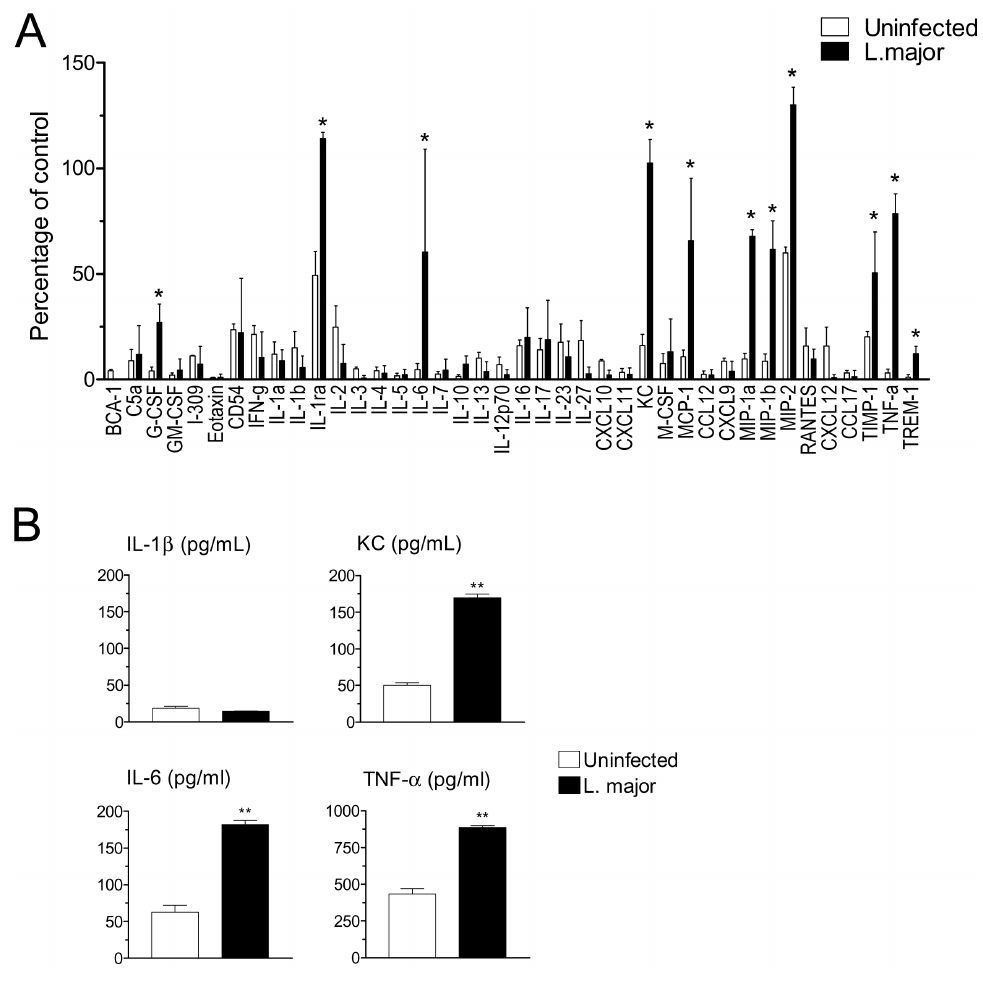
Figure 4. Induction of cytokine and chemokine release by L.major infection. (A) Resident B6 macrophages were infected (closed bars) or not (open bars) for 20 h with L. major , and supernatants were probed with a mouse cytokine array. The intensity of the labeling for each cytokine/ chemokine/mediator was quantitated and normalized as percentage of a positive control provided in the kit. Data indicate mean and SD of two independent arrays. Infected versus uninfected values were compared using non-parametric Mann-Whitney U-test. Cytokines showing a significant (P , 0.05) increase following infection are indicated by an asterisk. (B) Supernatants were also probed by ELISA for IL-1 b , KC, IL-6 and TNF- a , as indicated. ** P ,